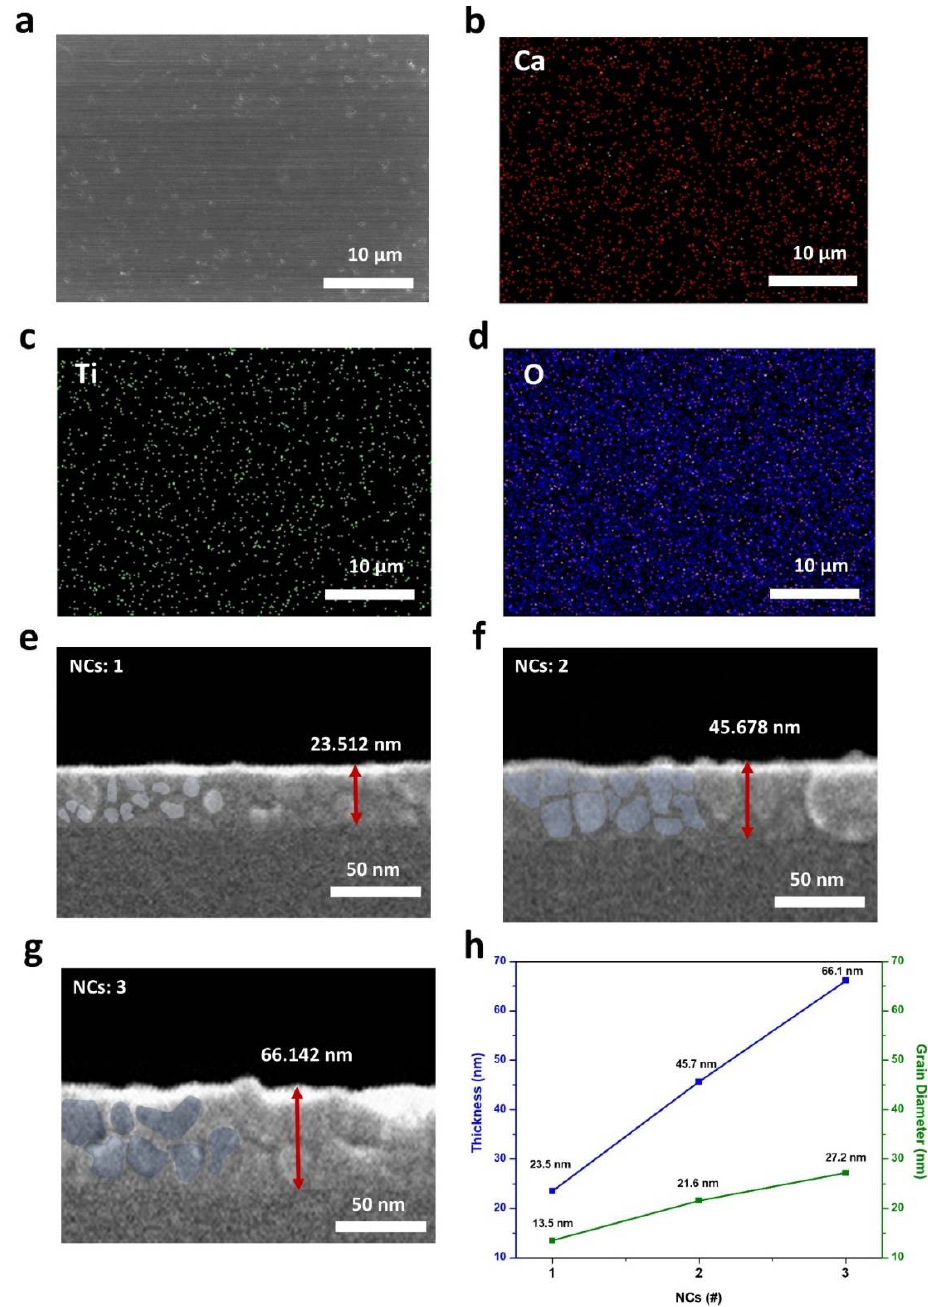
Figure 4. ( a ) Surface SEM image of the CTO film and elemental distribution images of ( b ) Ca, ( c ) Ti, ( d ) O. Cross-sectional SEM images of CTO films varied with the number of coatings where thicknesses are 24.512 nm at ( e ) NCs: 1, 45.678 nm at ( f ) NCs: 2, and 66.142 nm at ( g ) NCs: 3. ( h ) Thickness of the CTO and average diameter of grains under the effect of the number of spin-coating cycles. Figure 5a–c,d–f show 2D and 3D AFM images of three different CTO layers. The sur- face roughness factors, R a (average surface roughness) and R q (root mean squared surface roughness), were extracted from the measurements. The specific values of R a were 0.974, 1.194, and 1.667 nm for NCs: 1, NCs: 2, and NCs: 3. R q values were increased by the num- ber of spin coatings and measured to be 1.263, 1.573, and 2.511 nm, respectively. As shown in the images and parameter values, the increase in surface roughness was insignificant.